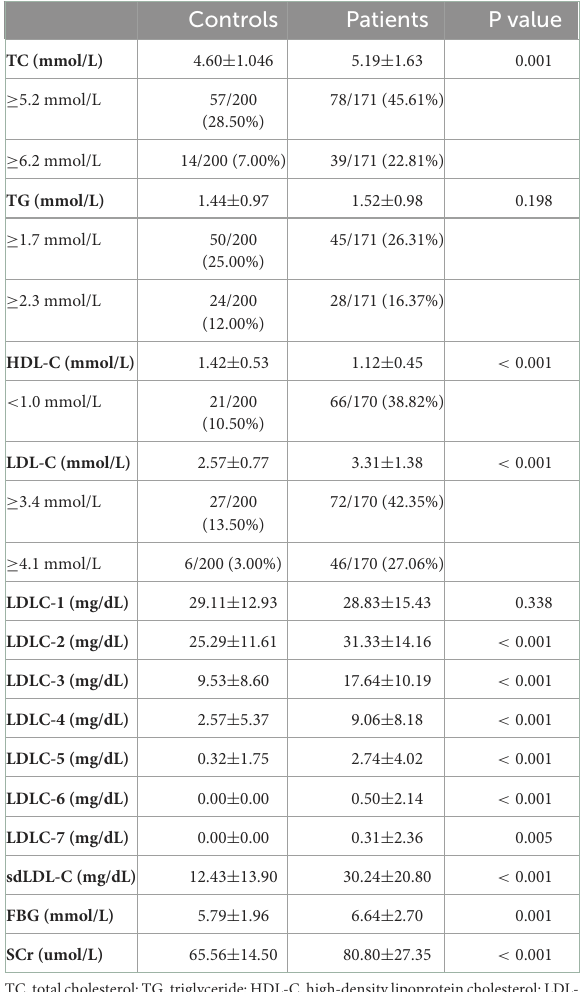
TABLE 2 Comparison of laboratory indices between non-CAD controls and CAD patients. Controls Patients